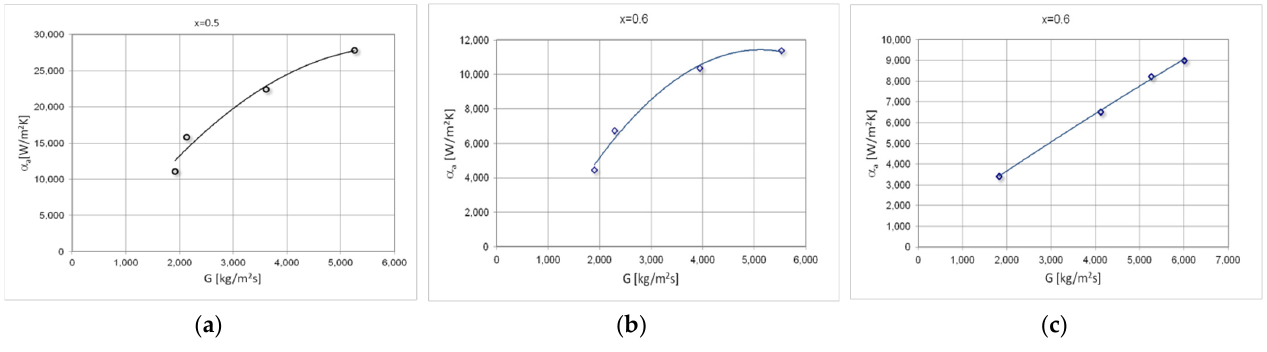
Figure 9. Experimental average flow characteristics of the heat transfer coefficient α a depending on the mass flow density G during condensation in a mini-channel with a hydraulic diameter d h = 0.5 mm (T s ≈ 50 °C), refrigerants: ( a ) HFE7100; ( b ) Novec649; ( c ) HFE7000.